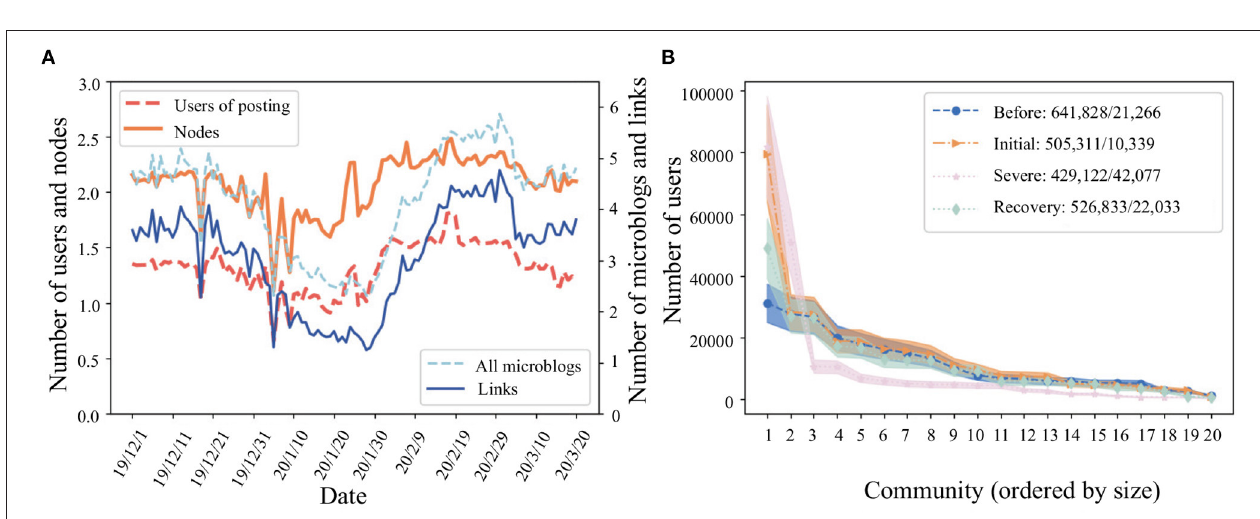
Frontiers in Public Health |